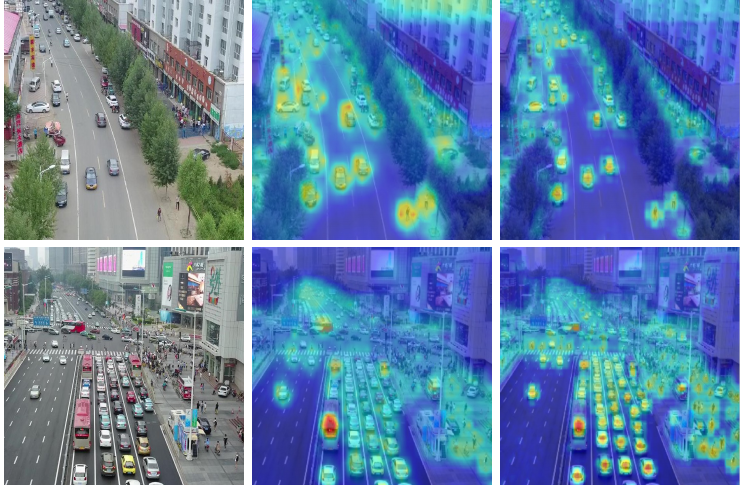
Figure 11. Heatmap comparison between our newly added head for lower-level features. The raw image ( left ), heatmap from the last second layer ( middle ), heatmap from the last layer ( right